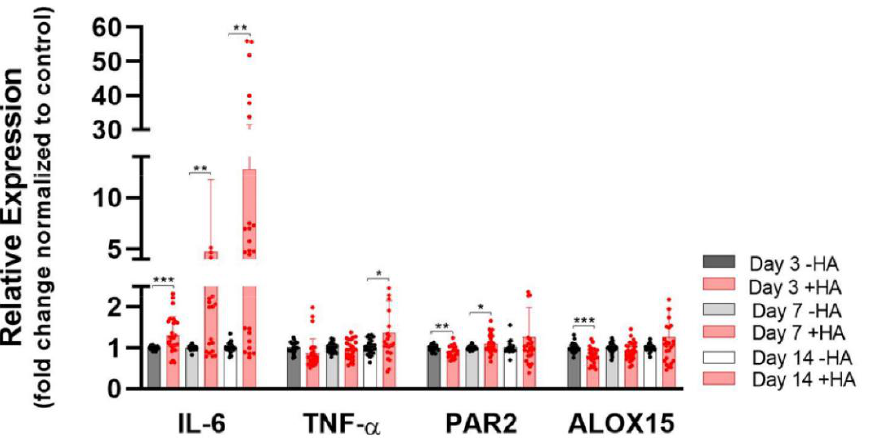
Figure 5. IL-6 , pro-inflammatory markers ( TNF- α and PAR2 ) and resolution marker ( ALOX 15 ) in the presence of HA compared with the control (without HA). Stars indicate pairwise comparison probability in Student’s t test , where HA was compared to the control: p < 0.05 (*), p < 0.01 (**) and p < 0.001 (***).